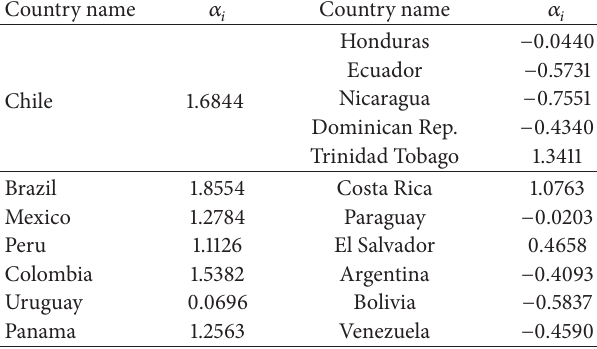
Table 4: Estimated values of the contagion model parameters. The value of model parameter 𝛽 𝑘(𝑖),𝑘 measures the contagion effect transmitted by the countries belonging to cluster 𝑘 ( 1 ≤ 𝑘 ≤ 4 ) on country 𝑖 ( 1 ≤ 𝑖 ≤ 18 ) belonging to cluster 𝑘(𝑖) according to assignment (5). Figures indicate that countries in clusters 𝑘 = 3, 4 have a remarkable influence on the others, being lower on Chile (columns 3 and 4). In addition, it can be observed that Chile